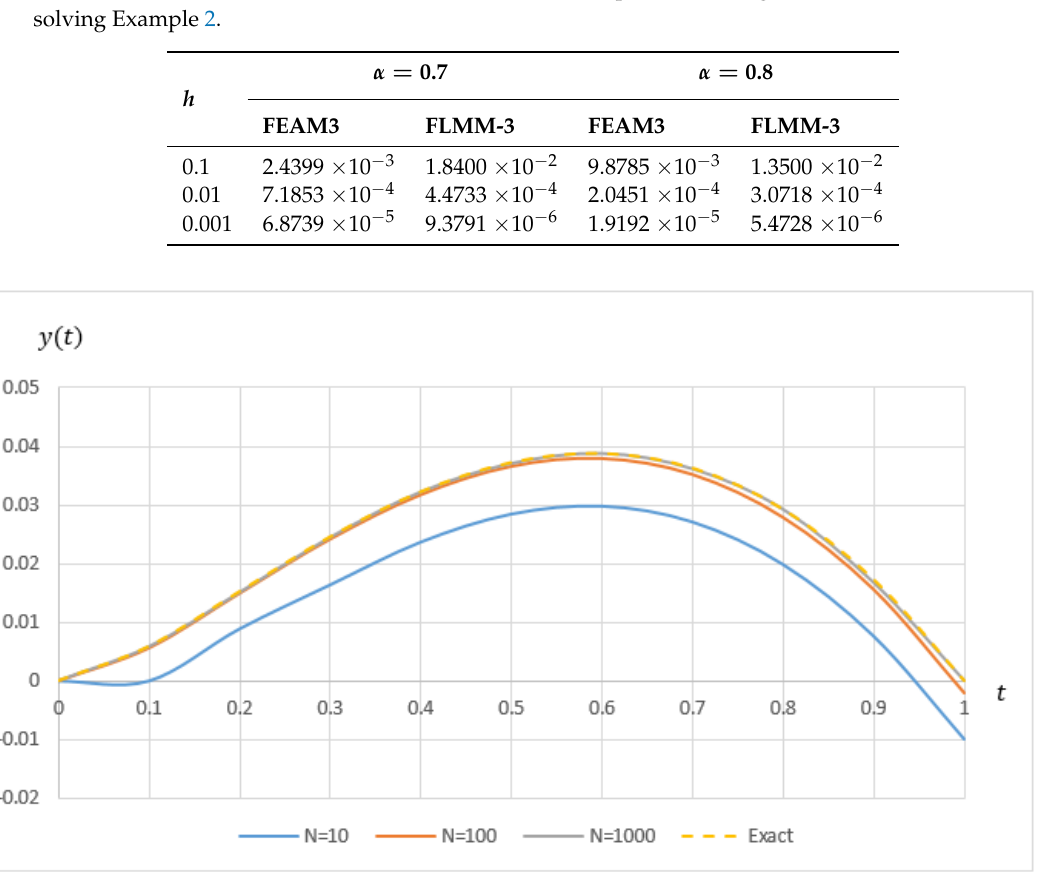
Figure 6. Approximate solution, y ( t ) against each point, t at different N of α = 0.50 when solving Example 2 using